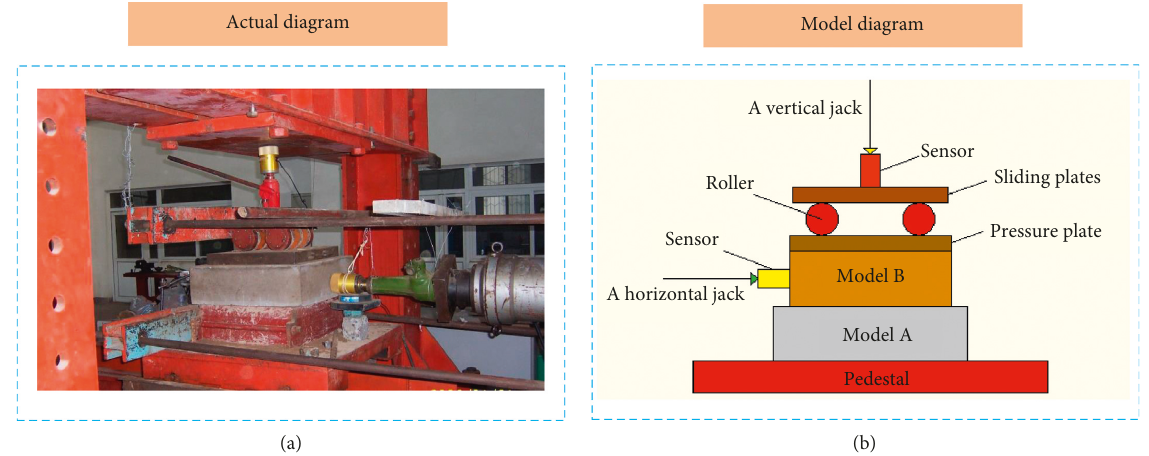
Figure 1: Test equipment of large-scale shear test.